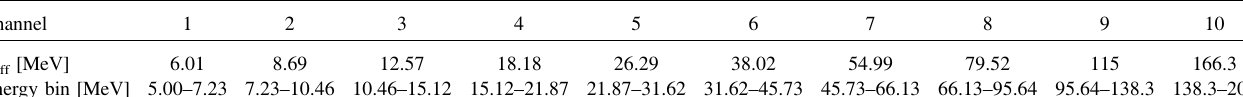
Table 1. The effective energies and energy bins of the RDSv2.